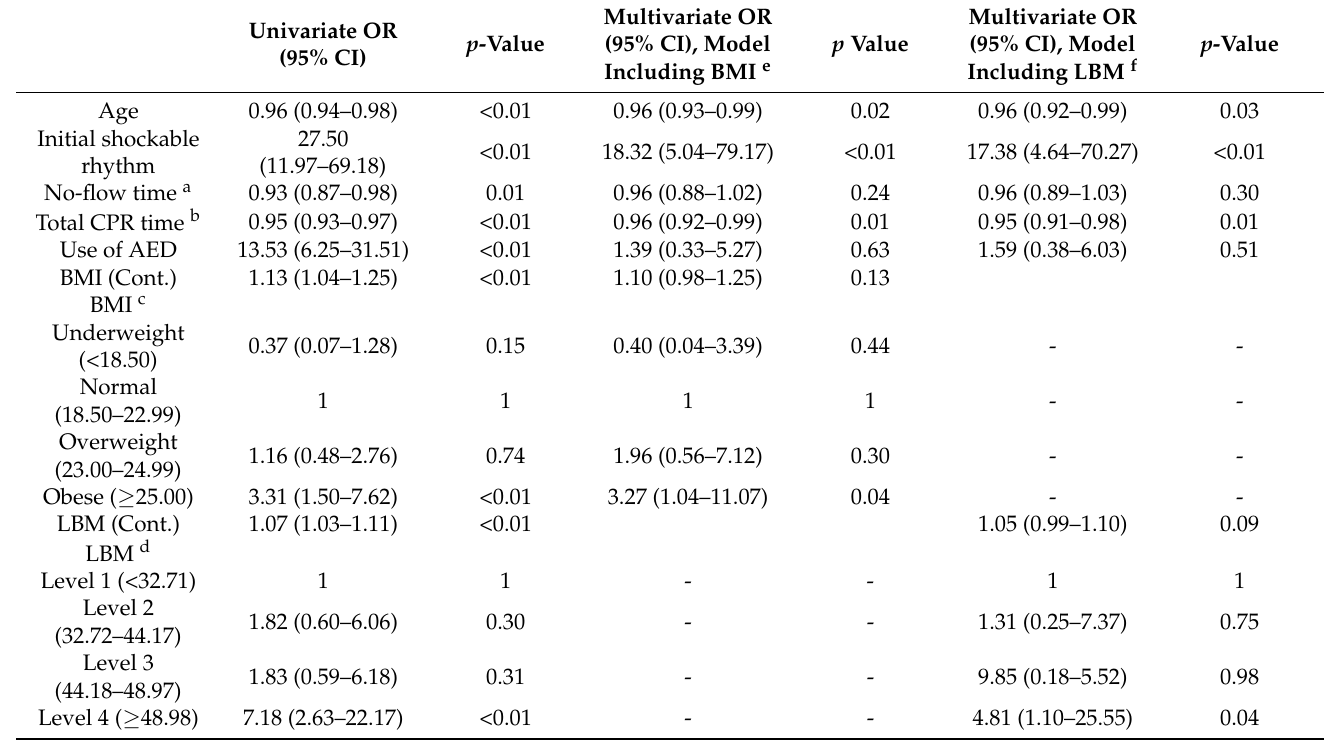
Table 2. Logistic regression models for clinical outcomes. Univariate odds ratios adjusted for multiple confounders.